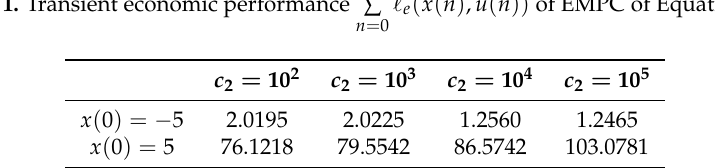
Table 1. Transient economic performance